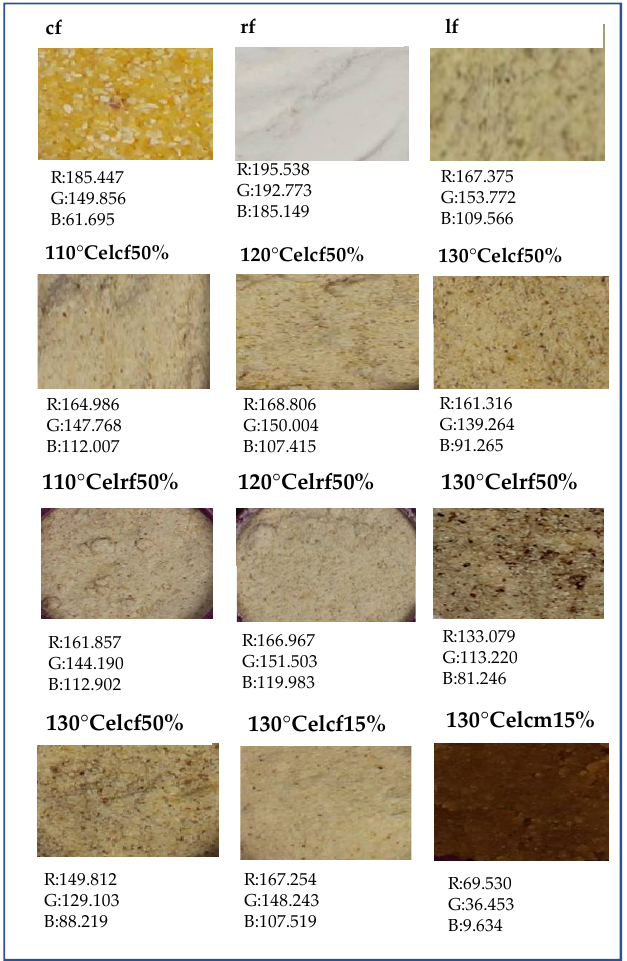
Figure 1. Image analysis (R: red; G: green; B; brown) of native and extruded flours. Abbreviations: cf: corn flour; rf: rice flour; lf: lentil flour; ecf: extruded corn flour; erf: extruded rice flour; elcf: extruded lentil (50% or 15%)-corn flour; elrf: extruded lentil (50% or 15%)-rice flour; elcm: baked product with extruded lentil-corn